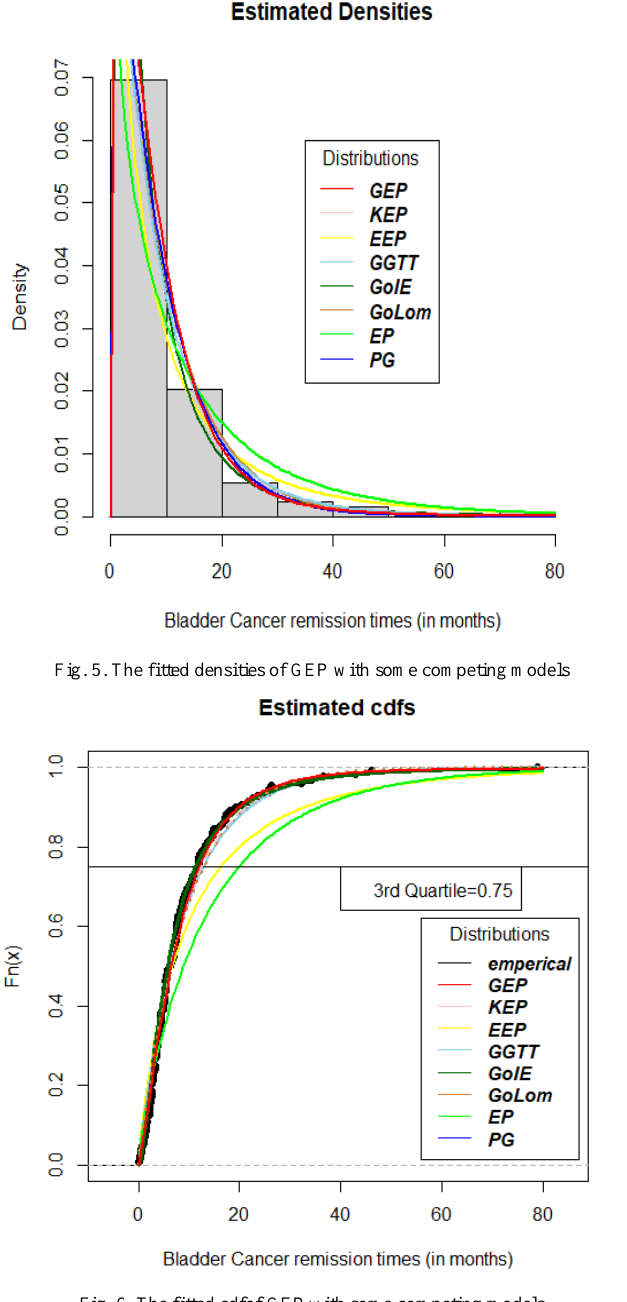
Fig. 6. The fitted cdfof GEP with some competing models